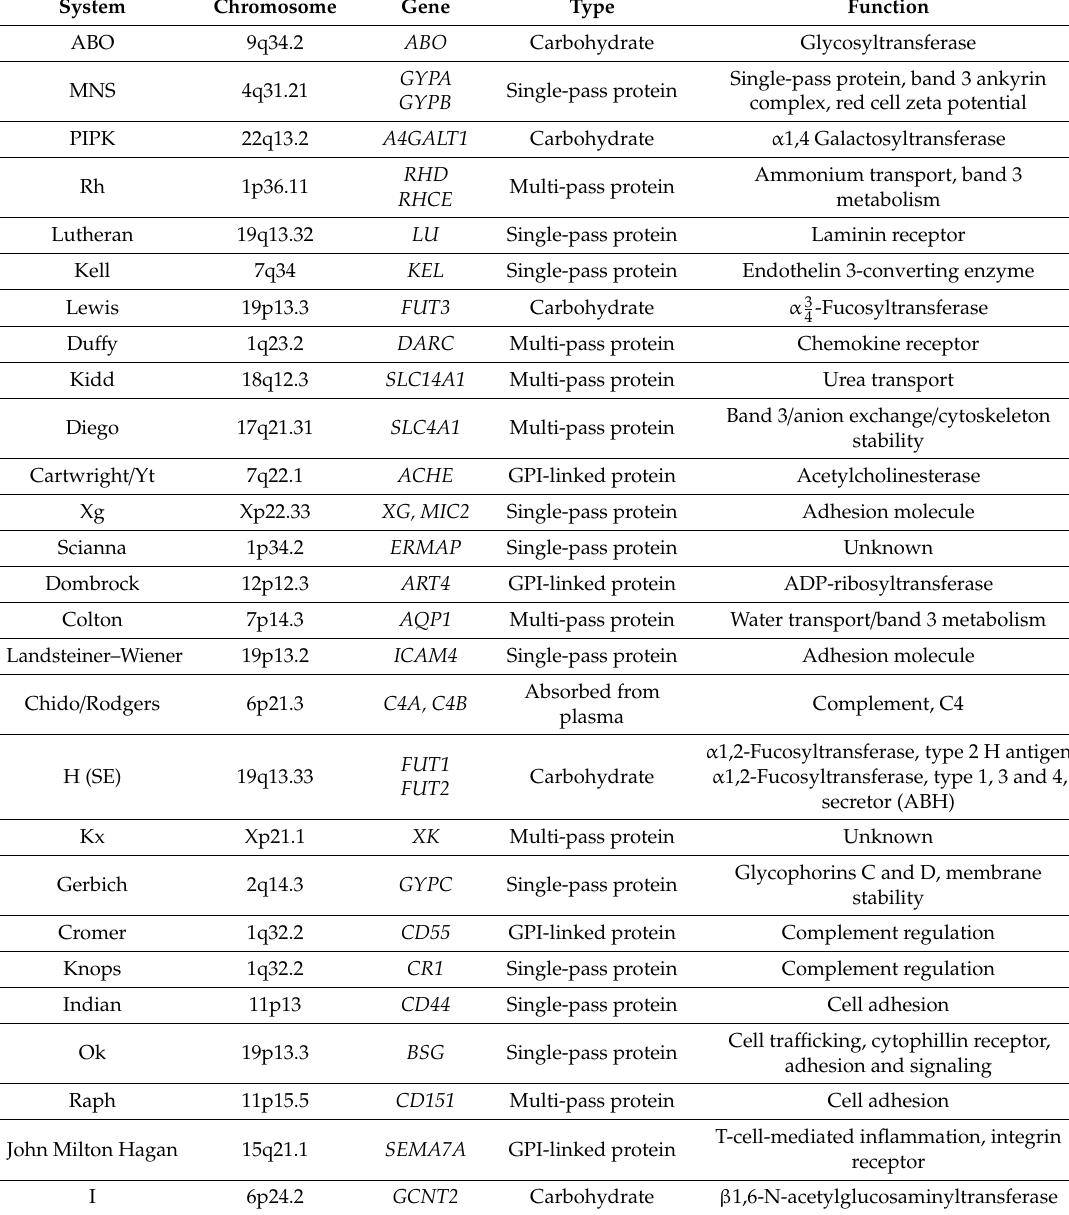
Table 1. Blood group systems recognized by the International Society of Blood